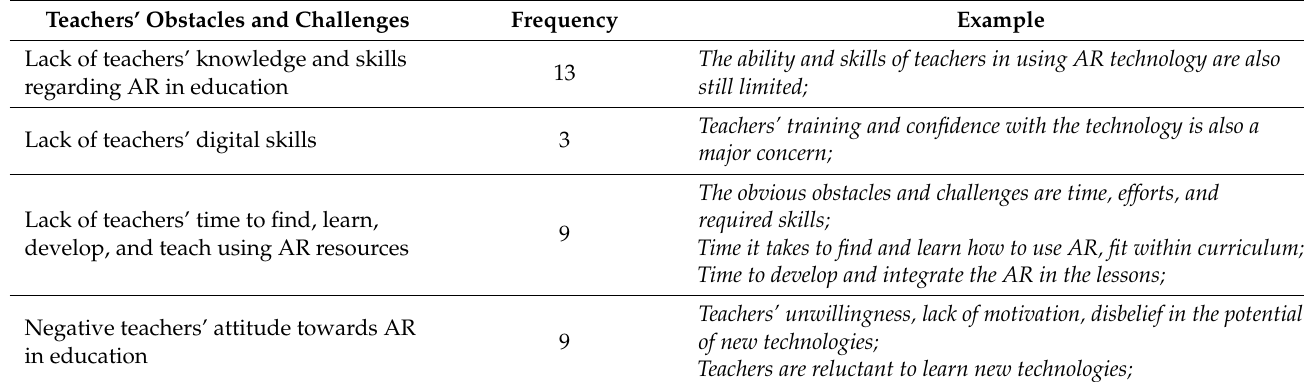
Table 14. Teachers’ obstacles and challenges in integrating